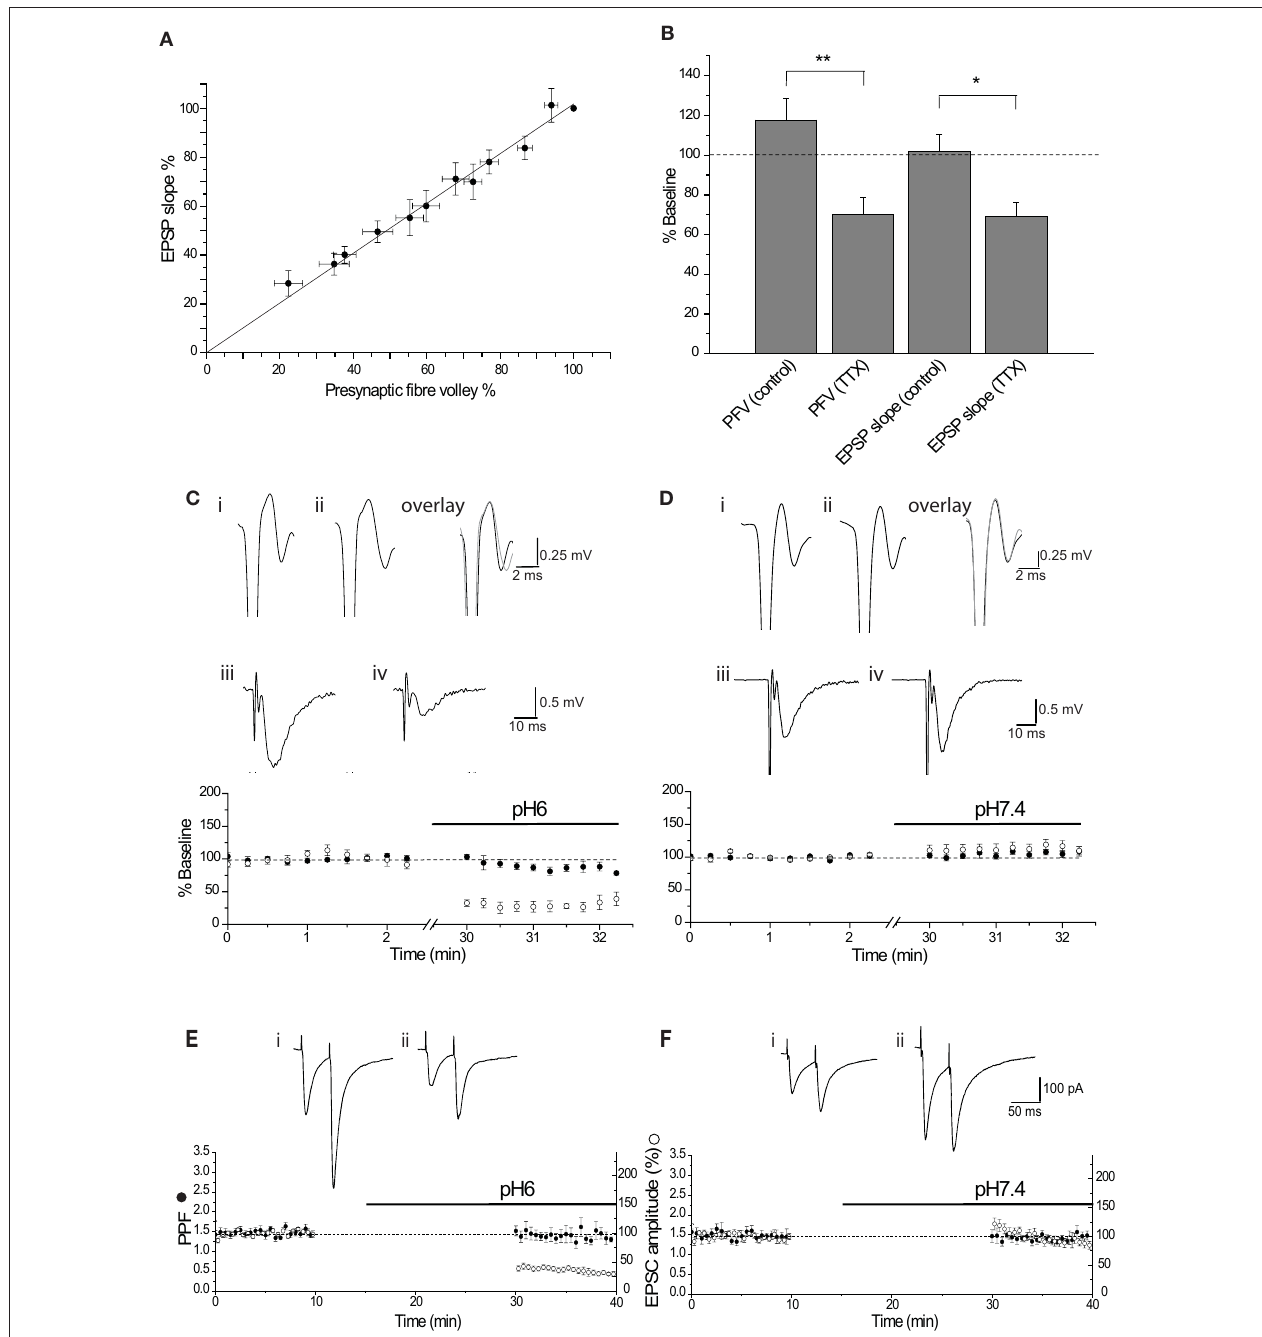
Figure 2 | The effect of pH6 aCSF is not mediated by presynaptic changes. (A) Relationship between the PFV amplitude and EPSP slope, determined by incrementally deceasing the stimulus intensity ( n = 8). Relationship was fit by linear regression, displaying a gradient of 1.02 ( R 2 = 0.992). (B) The relationship was also determined by superfusion of TTX (200 nM). Both methods show a 1:1 relationship between PFV amplitude and EPSP slope. (C) pH6 had little effect on the PFV amplitude (•) for the duration of the experiment (note the break in the time axis). This is illustrated by traces of the final control PFV (i), the first PFV evoked in pH6 (ii) and the overlay. In contrast, pH6 reduced the EPSP slope ( ○ ) by approximately 70%. This reduction is apparent in the traces of the